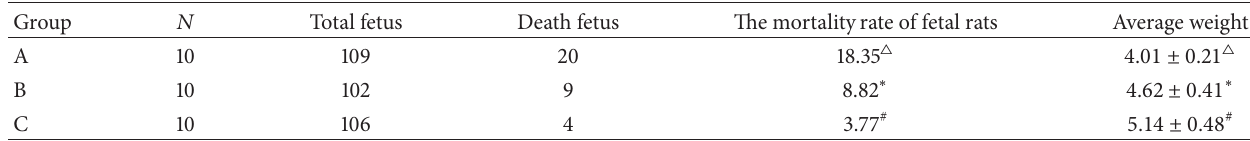
Table 4: Comparison of the growth and development of fetal rats in three groups.